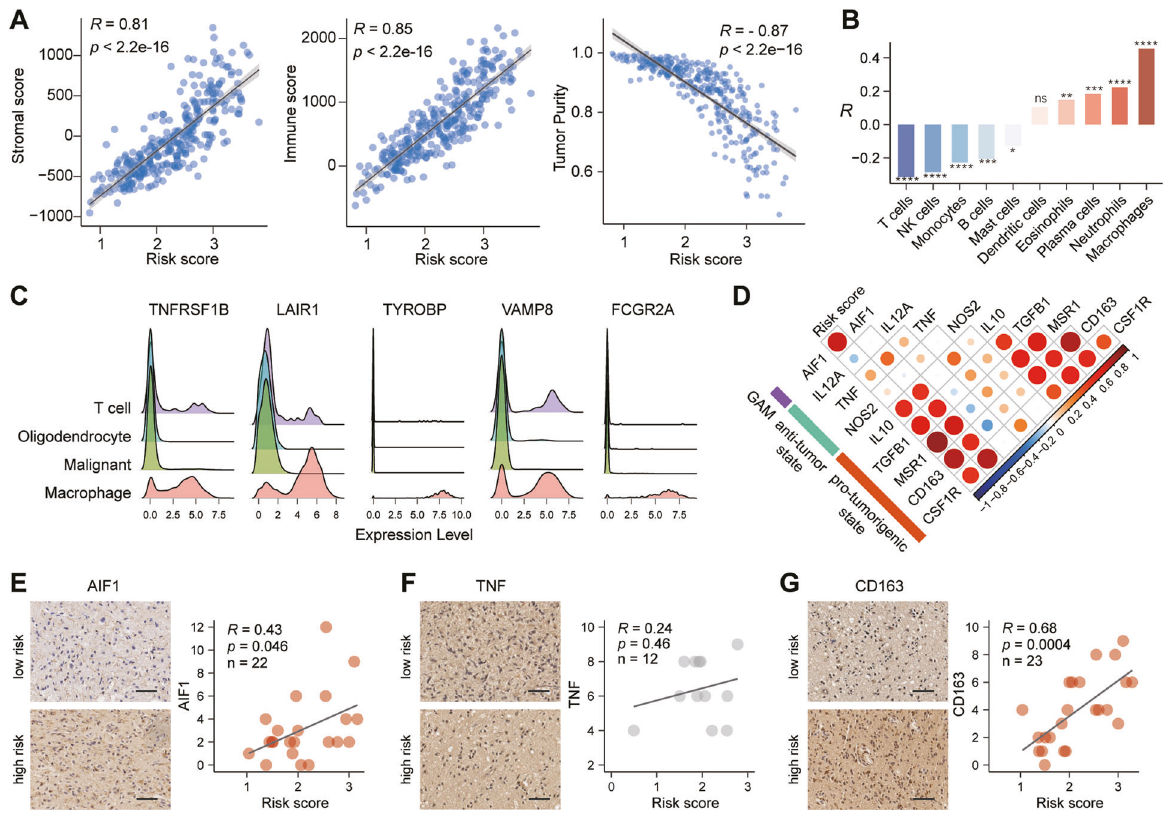
Fig. 6 The relationship between risk score and tumor microenvironment in the CGGA dataset. A Scatter plots showed the relationship between stroma score, immune score, or tumor purity and risk score. B The correlation between immune in fi ltrating cells and the risk score. ****, p < 0.0001; ***, p < 0.001; **, p < 0.01; *, p < 0.05; ns, no signi fi cance. C Expression of fi ve genes in single cells based on the GSE131928 database. D The correlation coef fi cient between risk score and glioma-associated microglia/macrophages markers. E − G The distribution of AIF1 ( E ), TNF ( F ) and CD163 ( G ) protein expression in the high- and low-risk groups by IHC staining. Scale bar, 50 μ